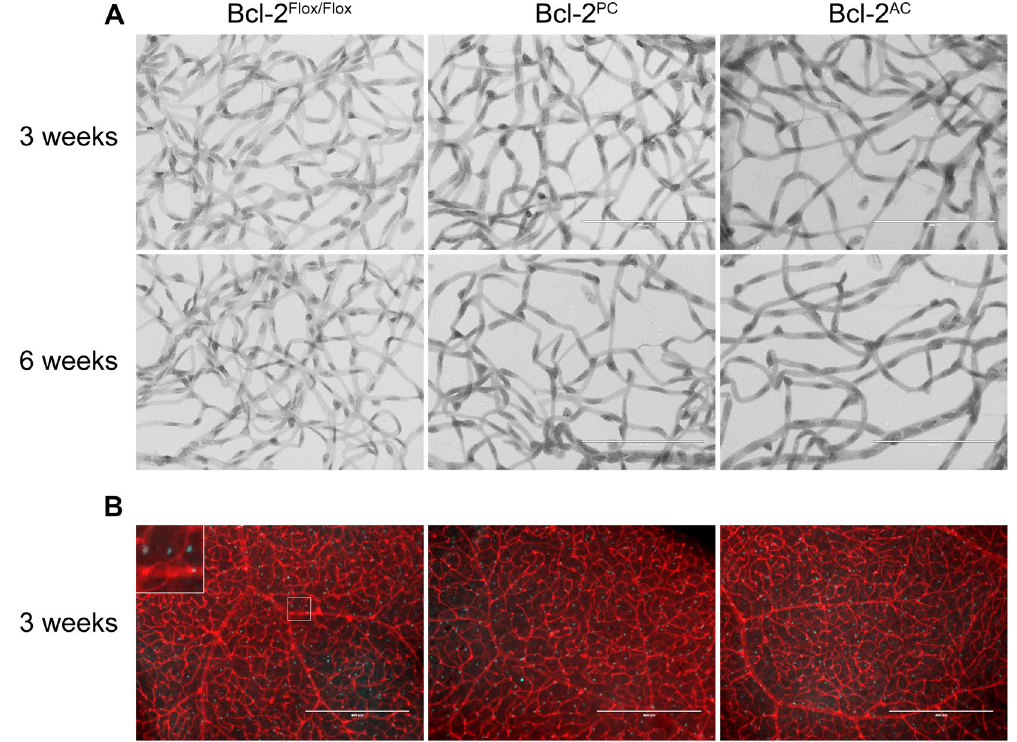
Figure 1. Decreased numbers of retinal endothelial cells and pericytes in conditional Bcl-2 mice. In Panel A, retinas from 3 week and 6 week old mice were prepared by trypsin digest followed by HE/PAS staining and quantification of endothelial cells and pericytes per x400 field of view. Scale bar = 100 µ m. In Panel B, retinas from 3 week old mice were stained with anti-Pax2 (blue) and Isolectin B4 (red) and astrocytes quantified. The inset magnifies the boxed area of interest 300%. Scale bar = 400 µ m. Four quadrants per eye were counted from > 6 eyes at each time point for the quantitative assessment of this data which is summarized in Table 1.